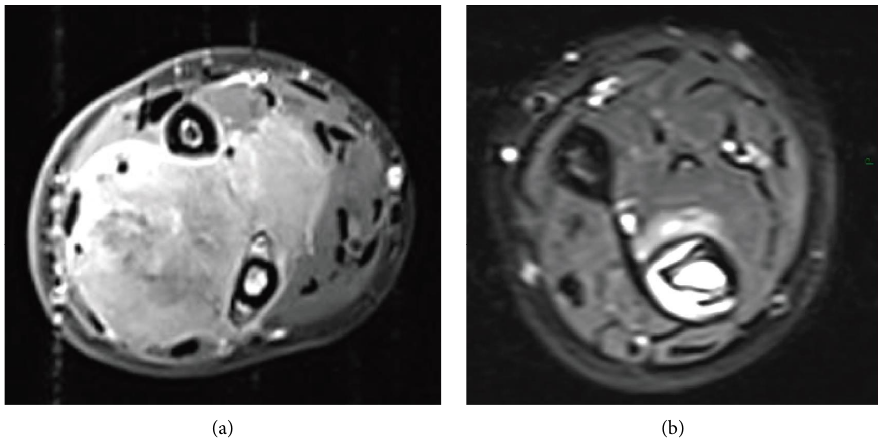
Figure 1: Patient 1 afected by voluminous Ewing’s sarcoma of the ulna. After neoadjuvant chemotherapy, the tumoral volume had been decreased, allowing resection. (a) Prior to chemotherapy. (b) After